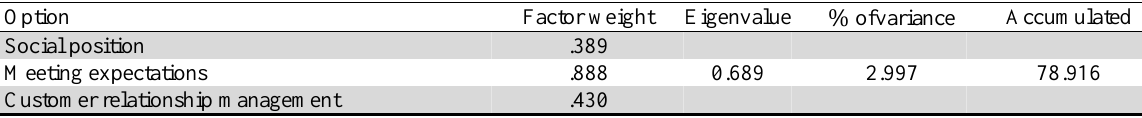
The summary of factors associated with brand